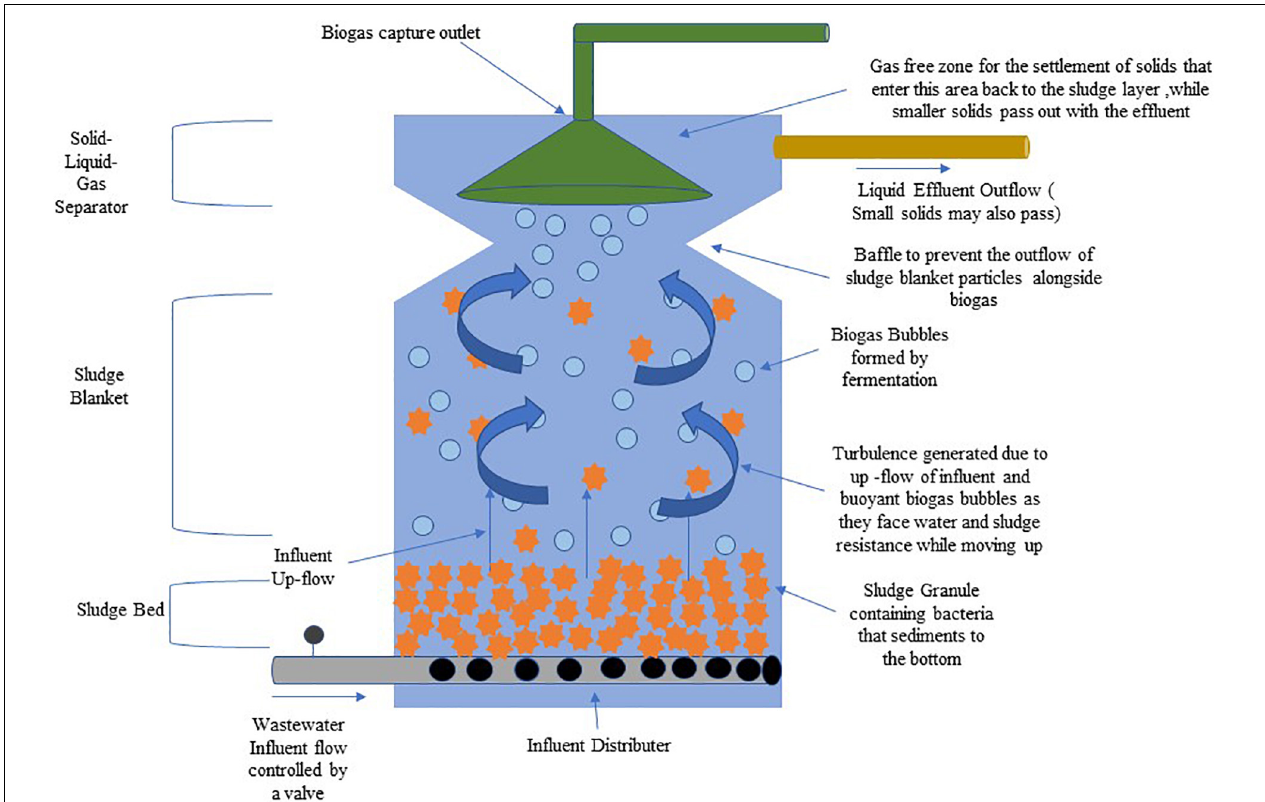
FIGURE 3 | Schematic of an up-flow anaerobic sludge blanket (UASB) reactor